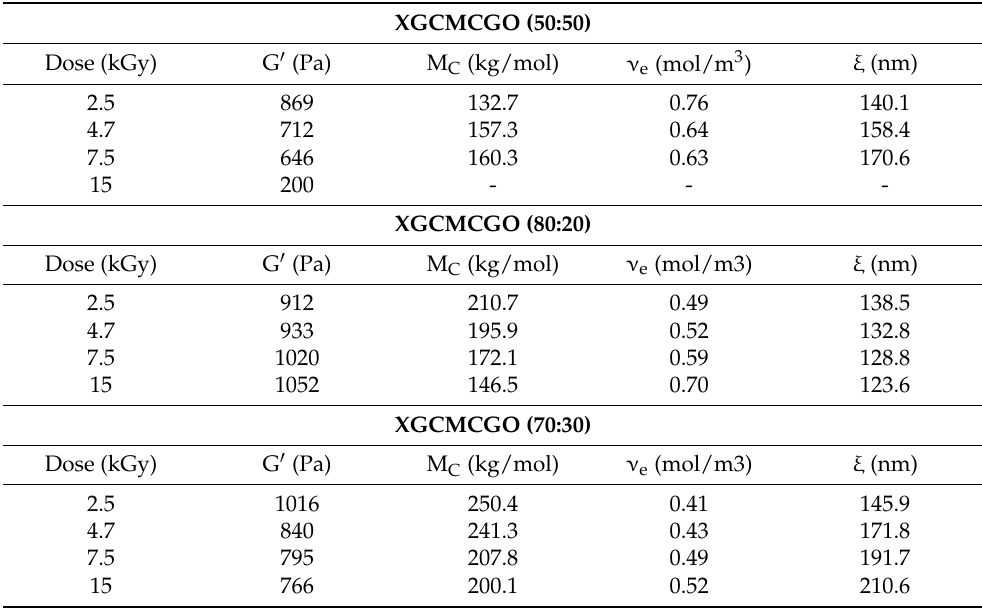
Figure 6. The FTIR spectra of unirradiated and irradiated dried hydrogels: ( a ) XGCMCGO (50:50); ( b ) XGCMCGO (80:20); ( c ) XGCMCGO (70:30). Table 4. The elastic modulus (G (cid:48) ), the molecular weight between two crosslinks of the hydrogel chains (M C ), the crosslink density ( ν e ), and network mesh size ( ξ ) of the XGCMCGO